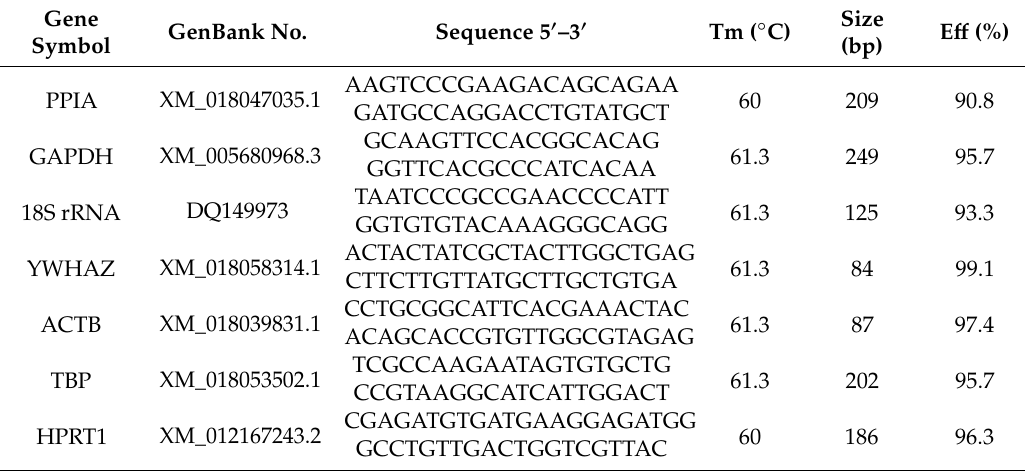
Table 1. Primer sequence information used in this